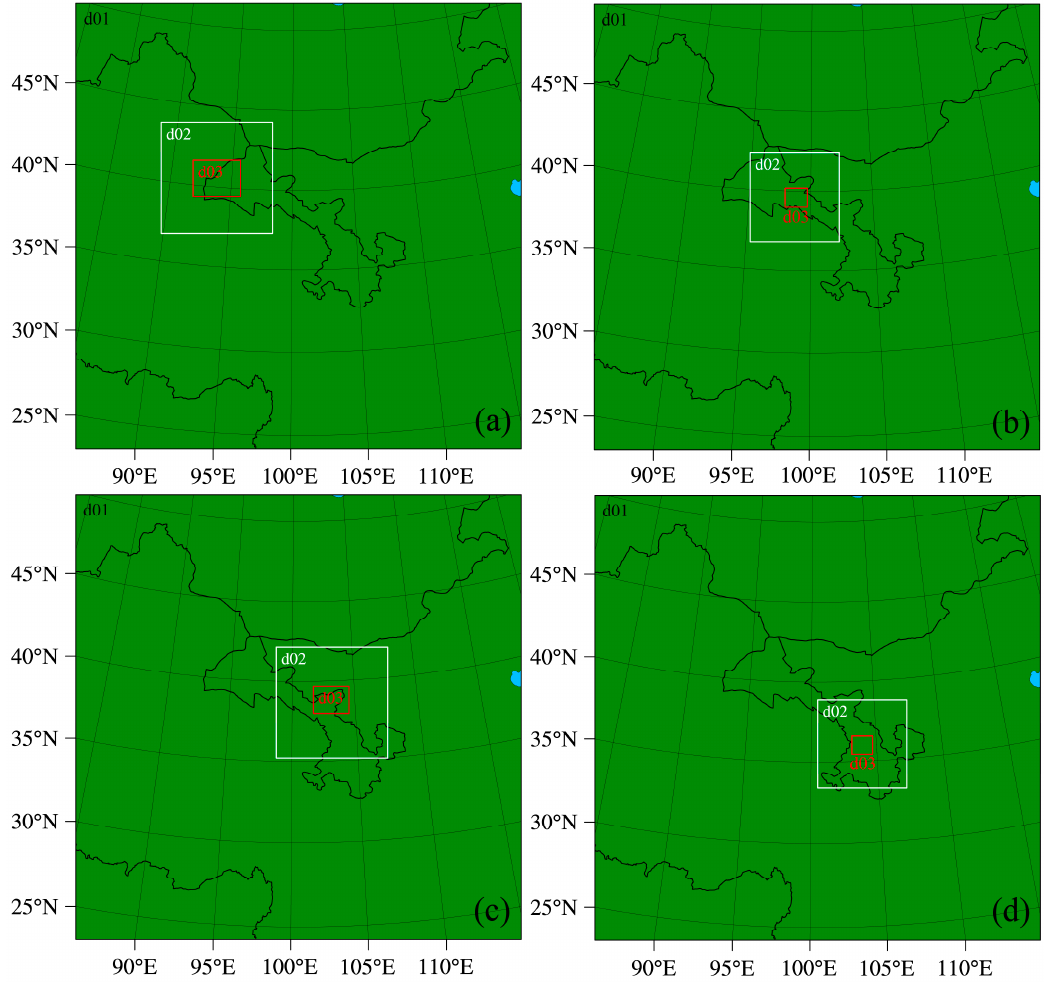
Figure 7. Triple nesting of simulation area: ( a ) Dunhuang, ( b ) Jiuquan, ( c ) Minqin, ( d ) Yuzhong and Lanzhou. The simulation time is from 00:00 BJT on 3 June 2016, to 00:00 BJT on 4 June 2016. During the simulation period, there are relatively deep-developed boundary layers in all five regions. The height of the boundary layer at 14:00 BJT was 4291 m in Dunhuang, 3618 m in Jiuquan, 4355 m in Minqin, 3079 m in Yuzhong, and 3172 m in Lanzhou.